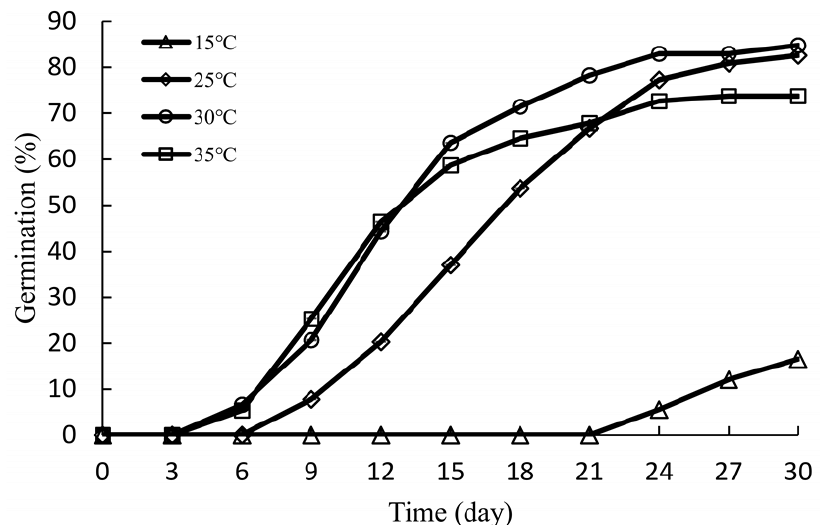
Figure 6. Germination of Ginkgo biloba ‘Jiafozhi’ seeds at different temperatures. Data are the means of three replicates ± SD.